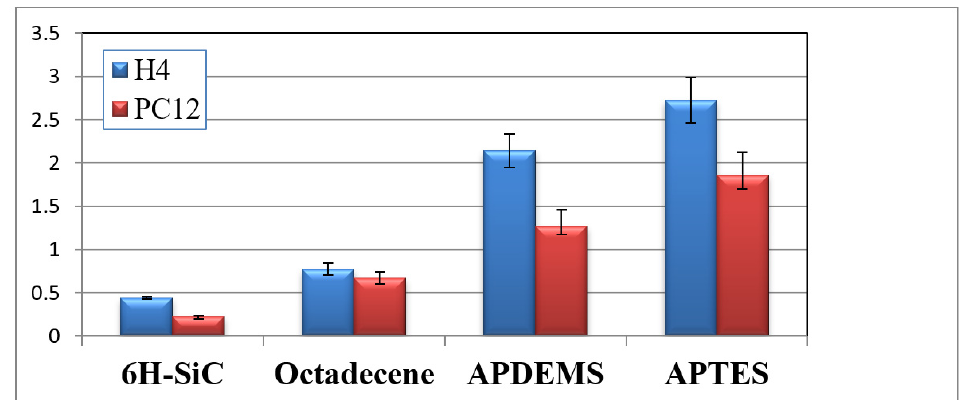
Figure 7. Proliferation of H4 and PC12 cell lines on (0001) 6H-SiC substrates vs. surface termination as determined by MTT assay analysis. The results are expressed as a sample distribution of the mean ( x ) and standard error of the mean ( σ M ), and normalized to the PSt readings ( n = 3) [19].